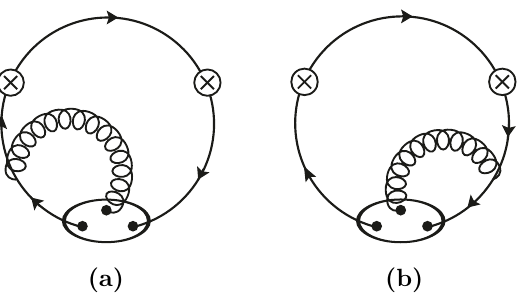
Figure 14. Feynman diagrams of the contribution of the quark-gluon condensate to the two-point Green functions due to the e(cid:11)ective propagation of the non-local quark condensate. Propagation of nonlocal quark